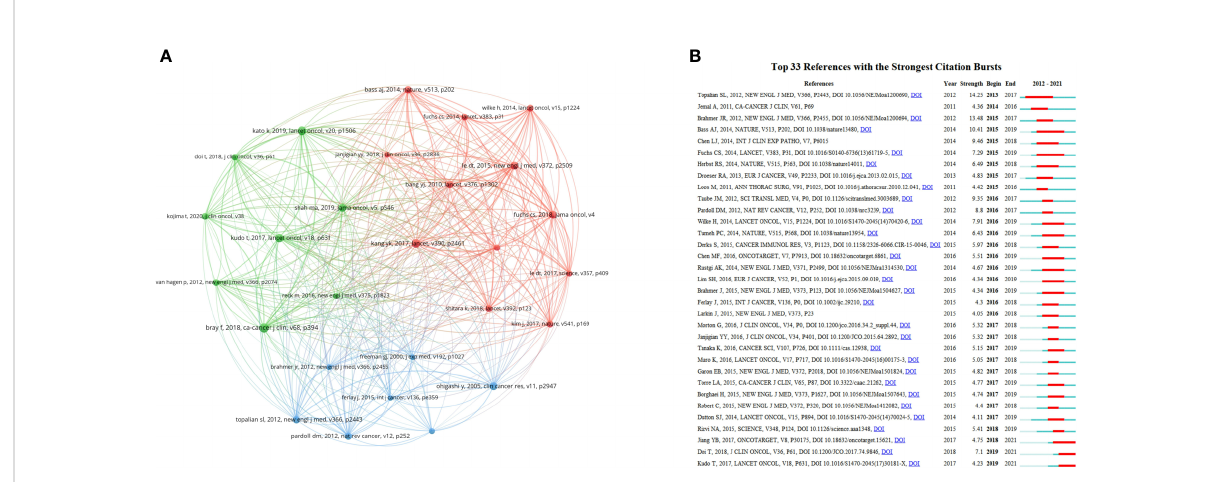
FIGURE 8 (A) The co-citation network visualization map of references from 2012 to 2021. (B) The top 33 references with the strongest citation bursts from 2012 to 2021. The red segment of the blue line denoted the burst duration of a